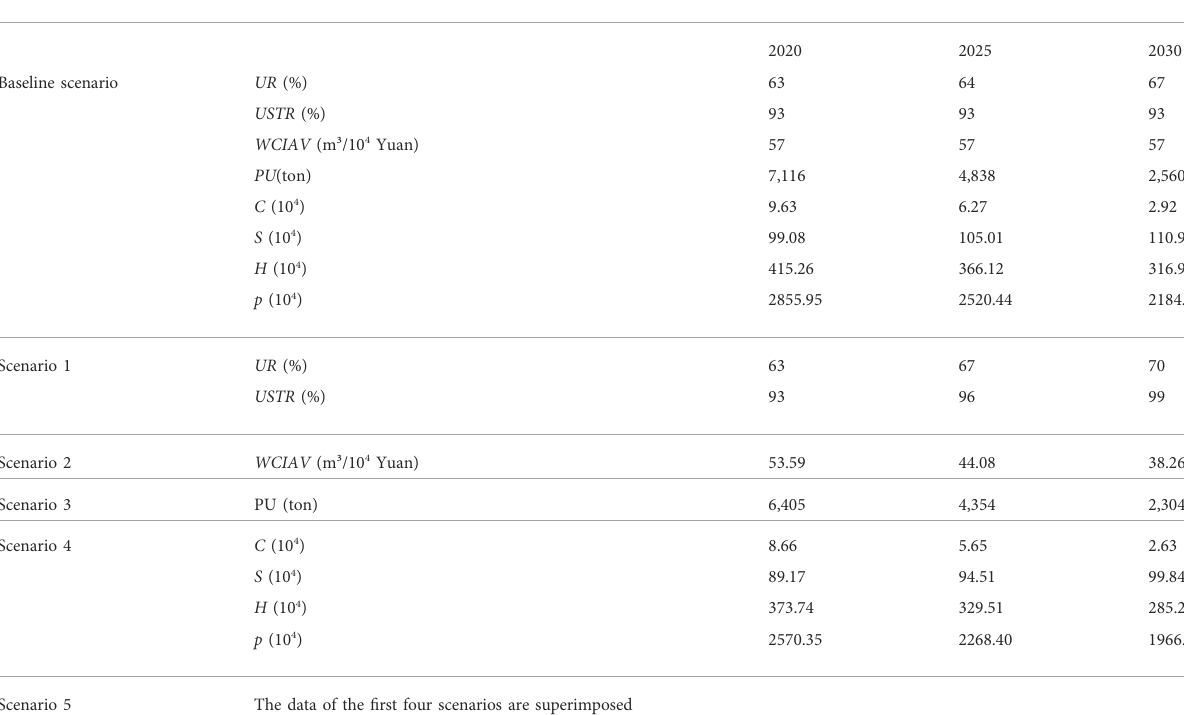
TABLE 3 Parameter of different scenarios.